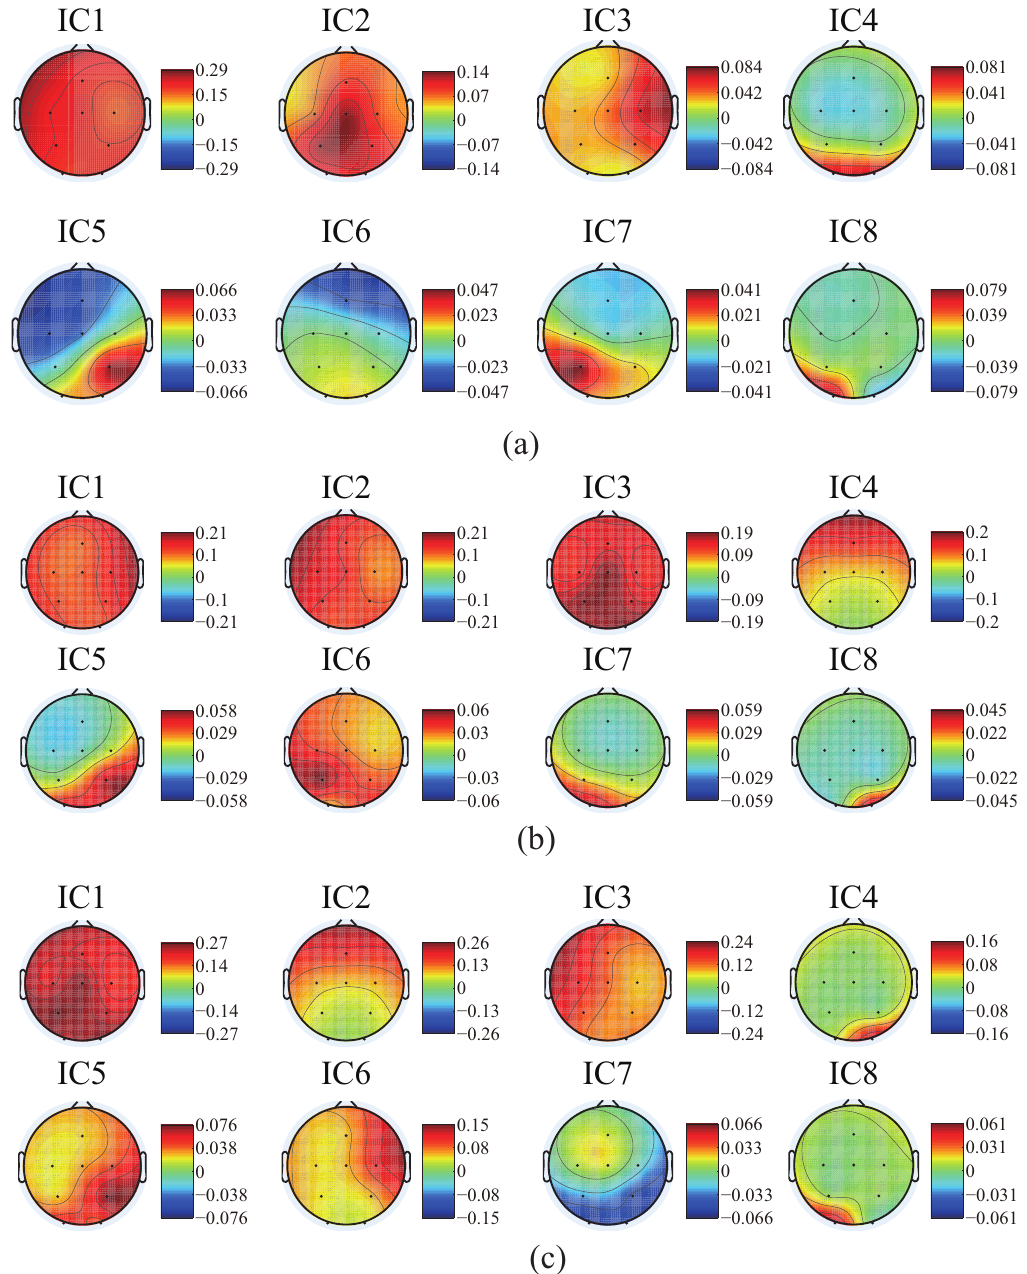
Figure 7. The average values of each independent component (IC) on the scalp of subject A ( a ), B ( b ) and C ( c ) based on the data in Figures